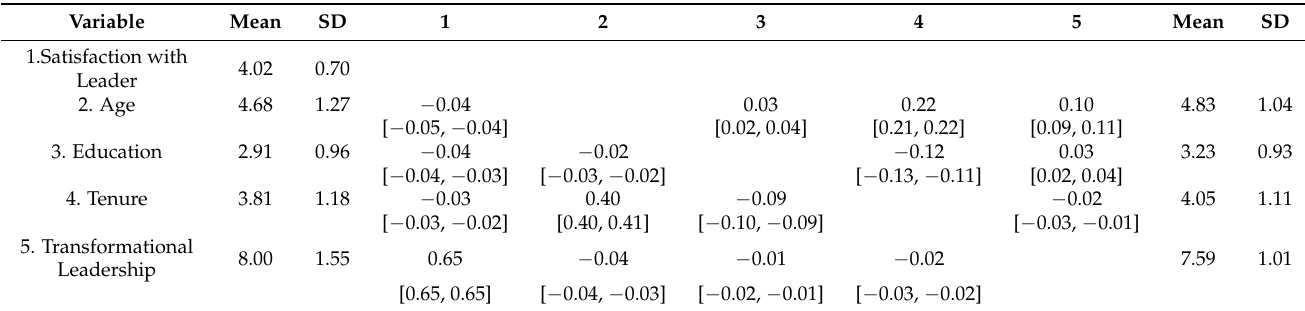
Table 1. Sample descriptive statistics a .